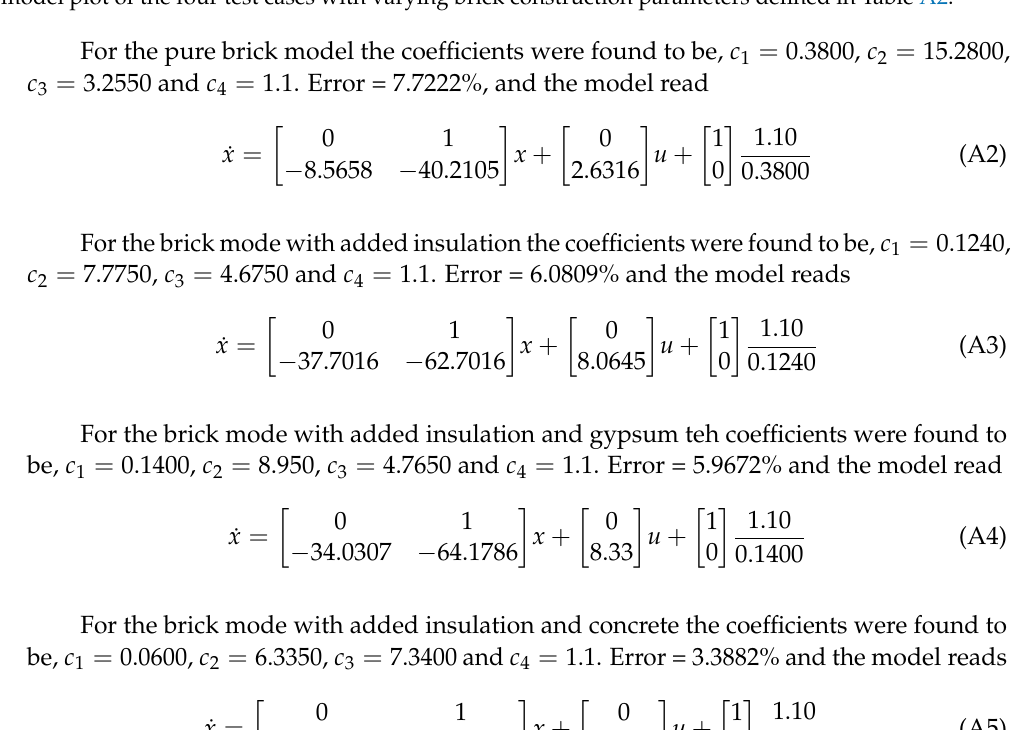
Figure A3. Second order model plot of the four test cases with varying brick construction parameters defined in Table